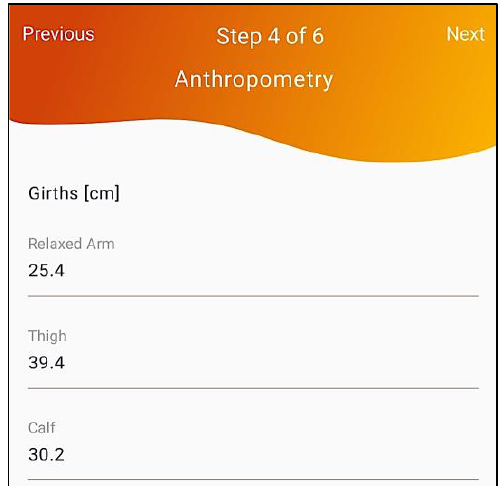
Figure 6. Anthropometric measures evaluation.